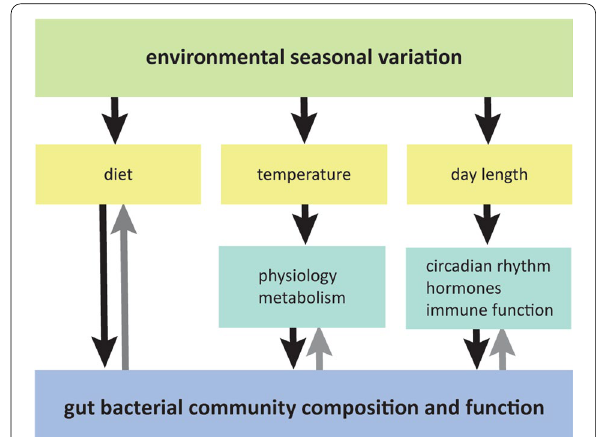
Fig. 1 Schematic overview of direct and indirect pathways via which season may impact the gut bacterial community. Yellow boxes indicate the three important aspects of seasonal environmental variation (diet, temperature, day length) that may impact the gut bacterial community. Green boxes indicate the host components of the indirect pathways. E.g., seasonal day length variation impacts the circadian system of the host, which will impact the gut bacterial community composition and function via seasonal variation in feeding patterns and circadian rhythms in hormone expression. On its turn, the gut bacterial community (blue box) impacts the host circadian system short chain fatty acids and bile acids production. Black arrows indicate the route of seasonal pathways modulating the gut bacterial community, grey arrows indicate modulation of the host by the gut bacterial